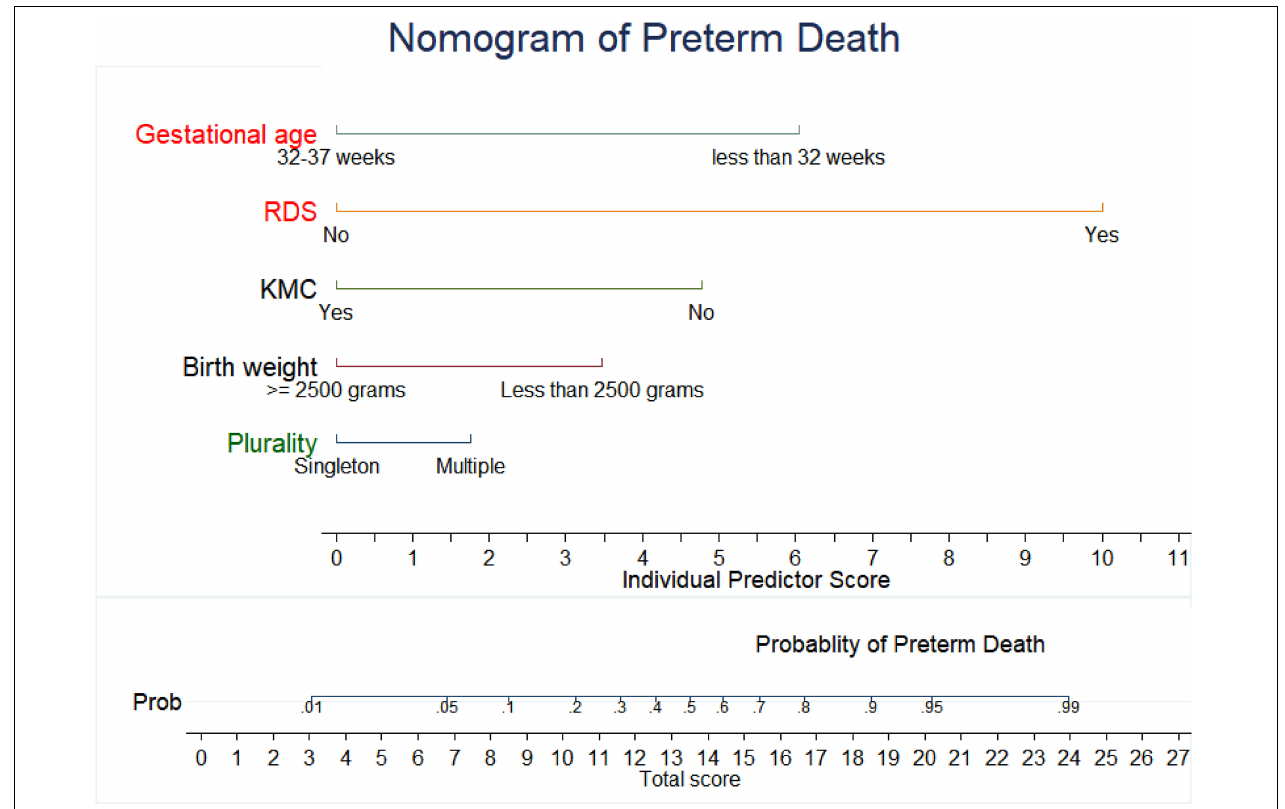
FIGURE 3 | Nomogram of a prognostic model to estimate the probability of preterm